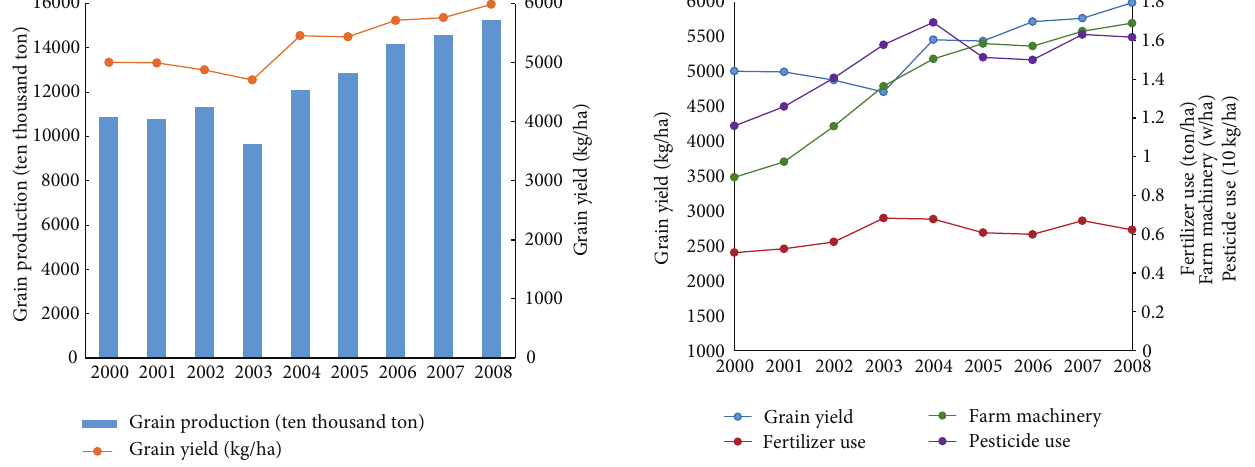
Figure 5: Changes of grain yield, fertilizer use, pesticide use, and farm machinery application of the North China Plain,